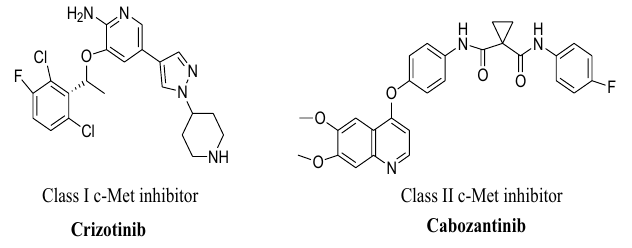
Figure 1. Representative type I and type II c-Met